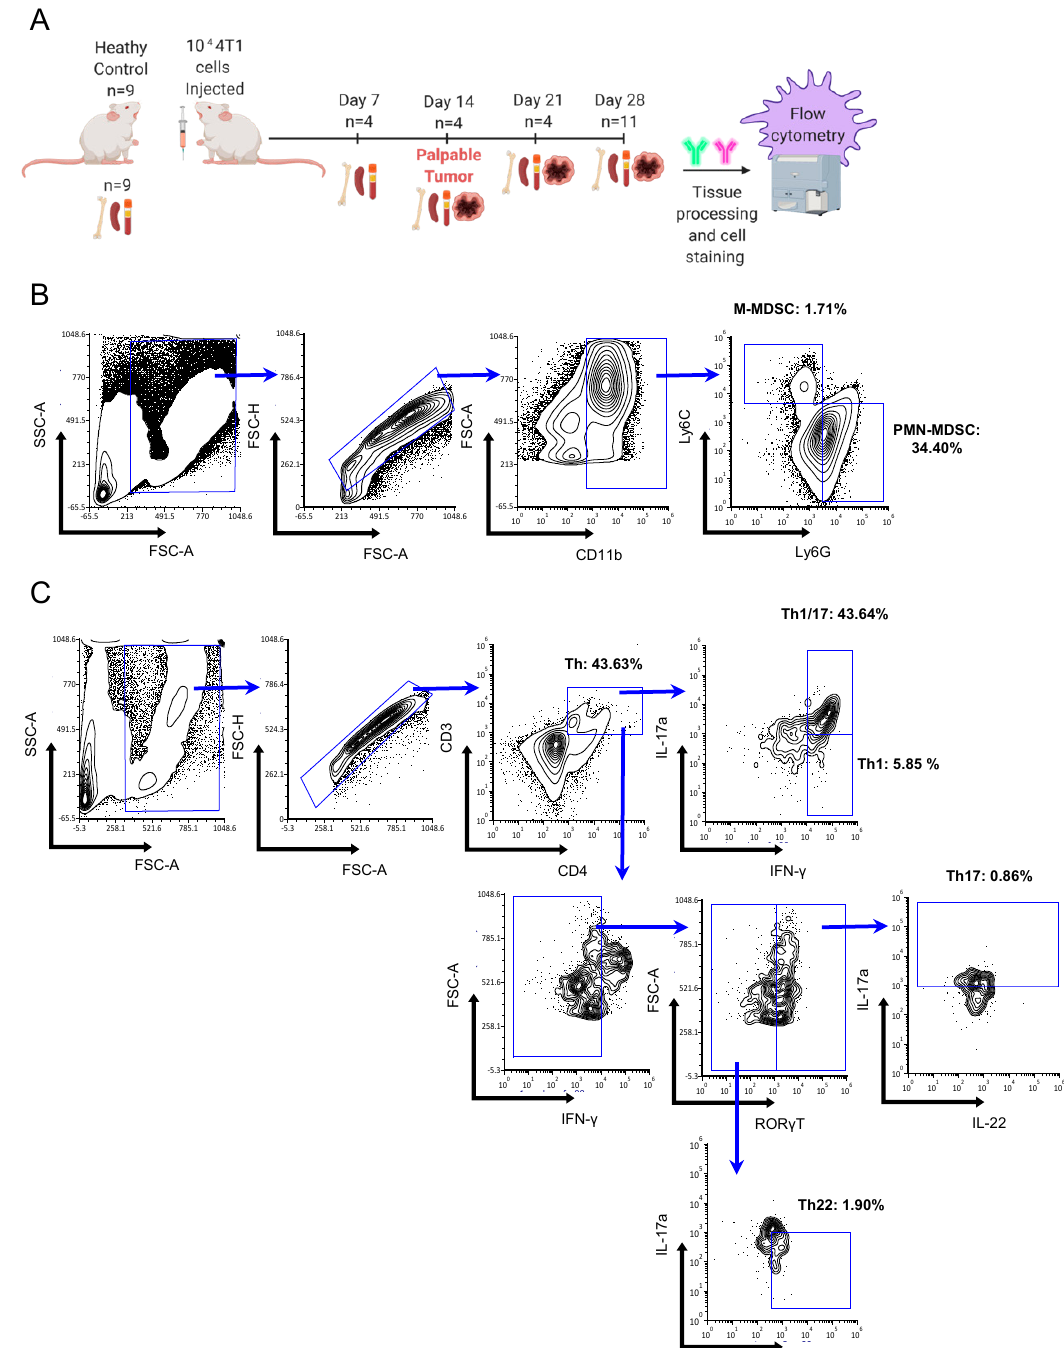
Figure 2. Time-course methodology and flow cytometry gating strategy. ( A ) Wild type 4T1 (4T1-WT, 10 4 cells) were injected into syngeneic BALB/cJ mice and spleen, blood, bone marrow, and tumor (when present) and were harvested 7, 14, 21, and 28 days later. The 4T1 mice formed palpable tumors 14 d after injection. Tissue was processed, stained, and analyzed by flow cytometry, with age-matched healthy non-tumor-bearing mice included for comparison. Representative blood sample shows gating strategies for ( B ) MDSC subtypes M-MDSC (CD11b + Ly-6G − Ly-6C hi ) and PMN-MDSC (CD11b + Ly- 6G + Ly-6C low ) as well as ( C ) CD3 + CD4 + T helper (T h ) subtypes T h 1 (CD3 + CD4 + IFN- γ + ROR γ t − IL- 17A − IL-22 +/ − ), T h 1/17 (CD3 + CD4 + ROR γ t + IFN- γ + IL-17A + IL-22 +/ − ), T h 17 (CD3 + CD4 + ROR γ t + IFN- + CD4 + IFN- γ − ROR γ t − IL-17A − IL-22 + γ − IL-17A + IL-22 +/ − ), and T h 22 (CD3